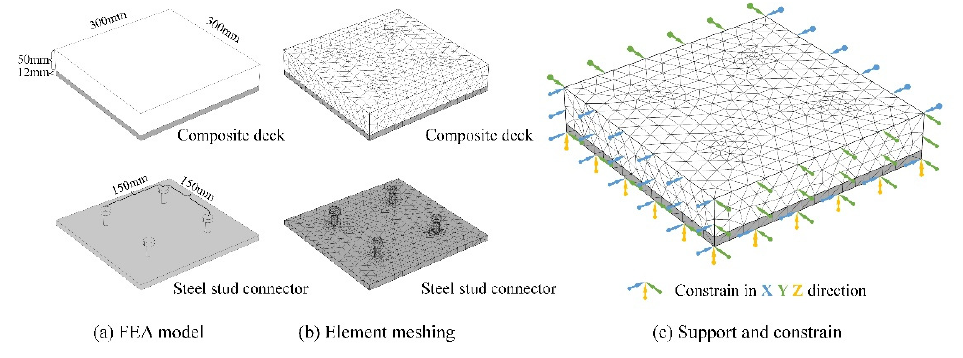
Figure 6. Illustration of FEA model, element meshing, and boundary-condition setting.